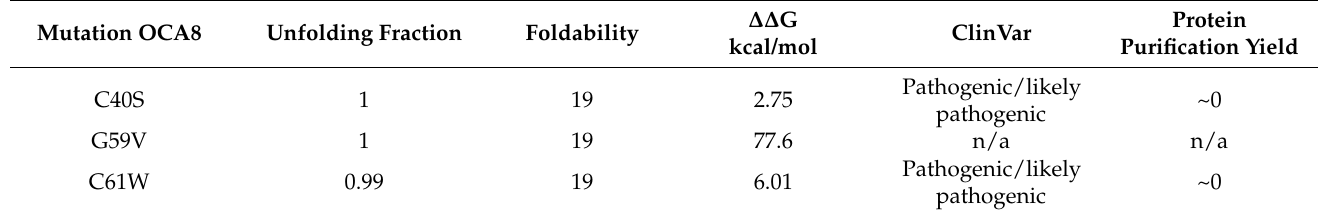
Figure 5. The stability of the human recombinant Tyrp2 and OCA8-related mutant variants. Chro- matography profiles of Tyrp2 (red) and mutant variants (C40S, blue, and C61W, grey) eluted from the Sephacryl S-300 HR column followed after IMAC ( A ) and Superdex 200 Increase GL 10/300 column ( B ). The picks of protein of interest are in grey boxes. The black dotted line corresponds to the Bio-Rad GF standards. Insert shows the Western blot of Tyrp2, and OCA8-related mutants using anti-Tyrp2 B7 antibody. Inserts from the left: Tyrp2, C40S, and C61W. Lanes in each insert: M, protein ladder; L, lysate; 1, Tyrp2; 2, C40S, and 3, C61W. Table 2. Global mutagenesis of Tyrp2 homology model, recombinant Tyrp2 purification yield, and clinical significance of mutation from ClinVar (https://www.ncbi.nlm.nih.gov/clinvar ; accessed on 20 January 2022).